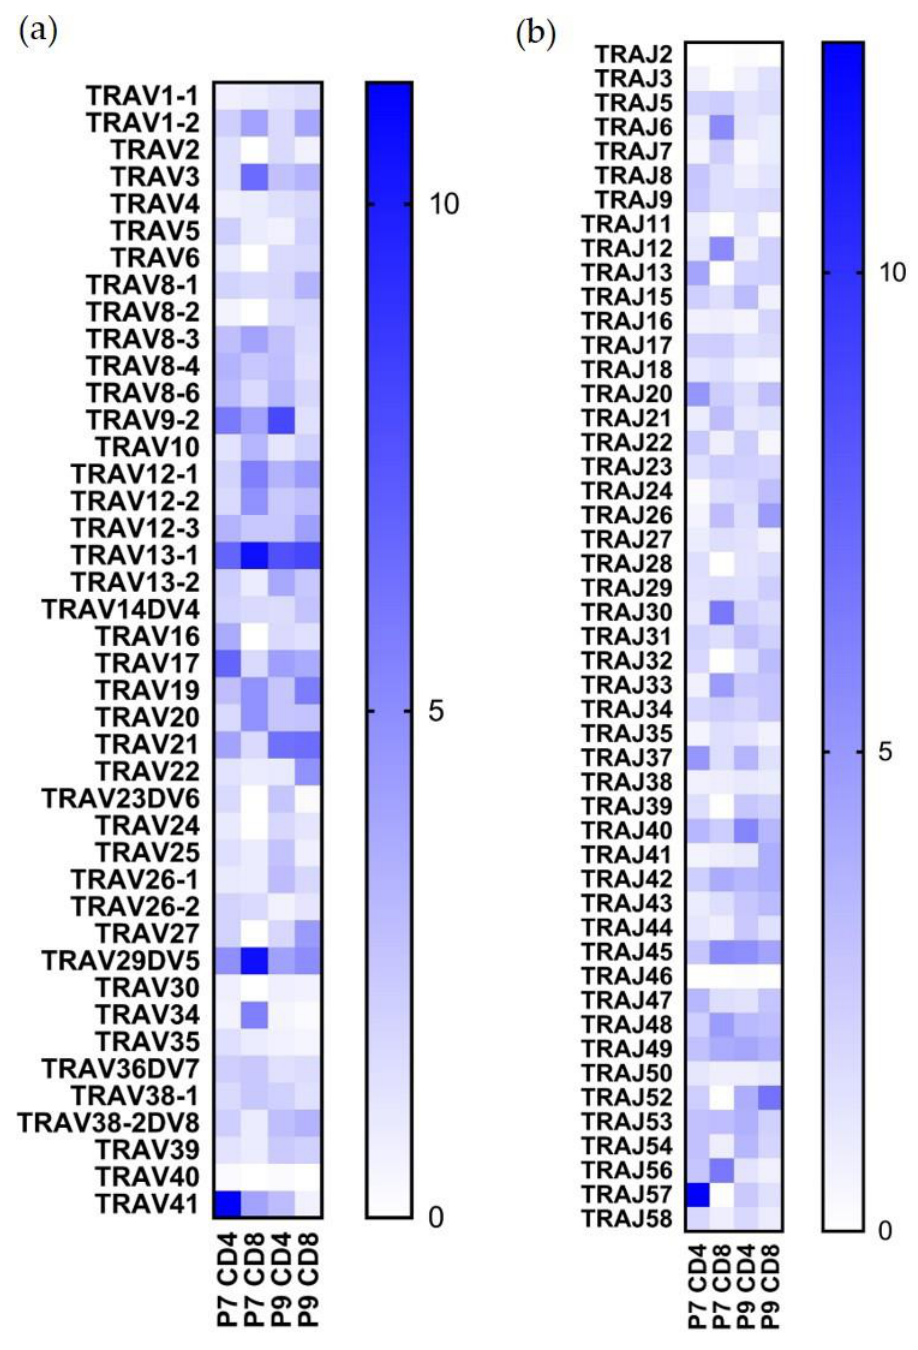
Figure 3. TRAV and TRAJ usage in Ni 2+ -reactive CD4+ and CD8+ T cell clones in subjects P7 and P9. ( a ) Percentage of the TRAV gene usage. ( b ) Percentage of the TRAJ gene usage. All the gene names are in IMGT nomenclature. The scale shows the percentage use in each of the four designated populations.